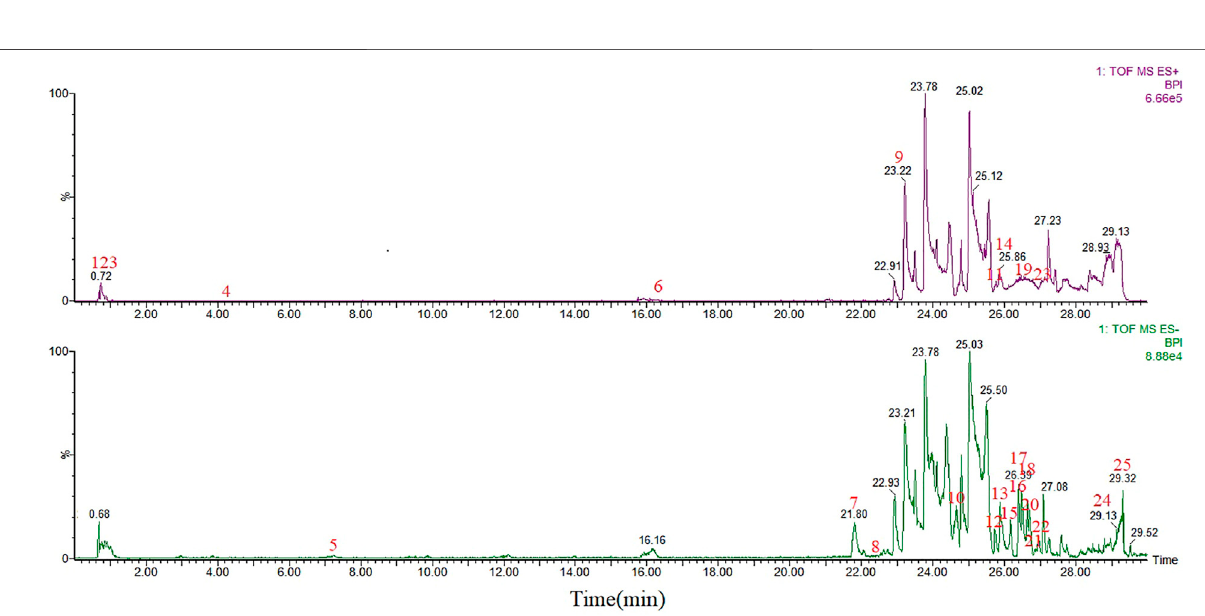
FIGURE 3 | UPLC-MS base peak intensity chromatograms of serum after WK administration in negative and positive modes.